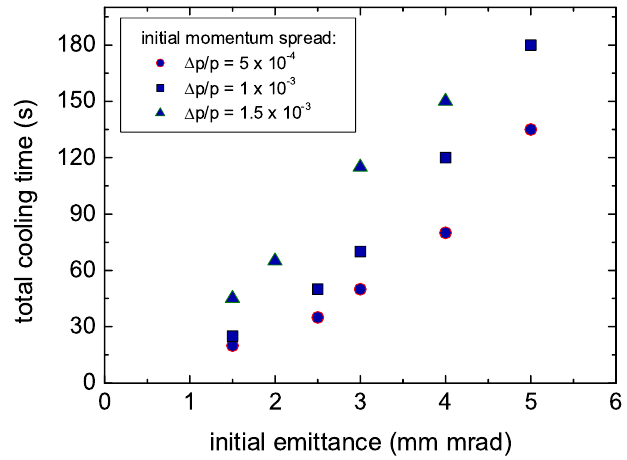
FIG. 6. (Color) Total cooling time for antiprotons at 800 MeVas a function of transverse emittance and for different initial momentum